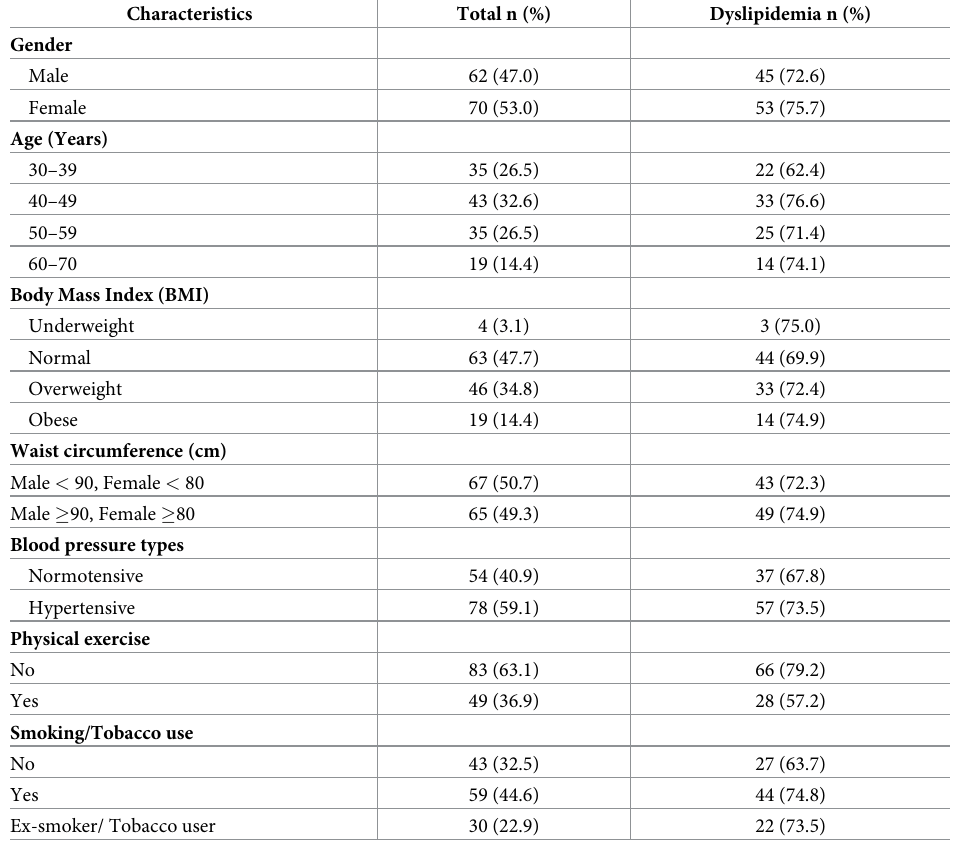
Table 1. T2DM respondents characteristics and dyslipidemia